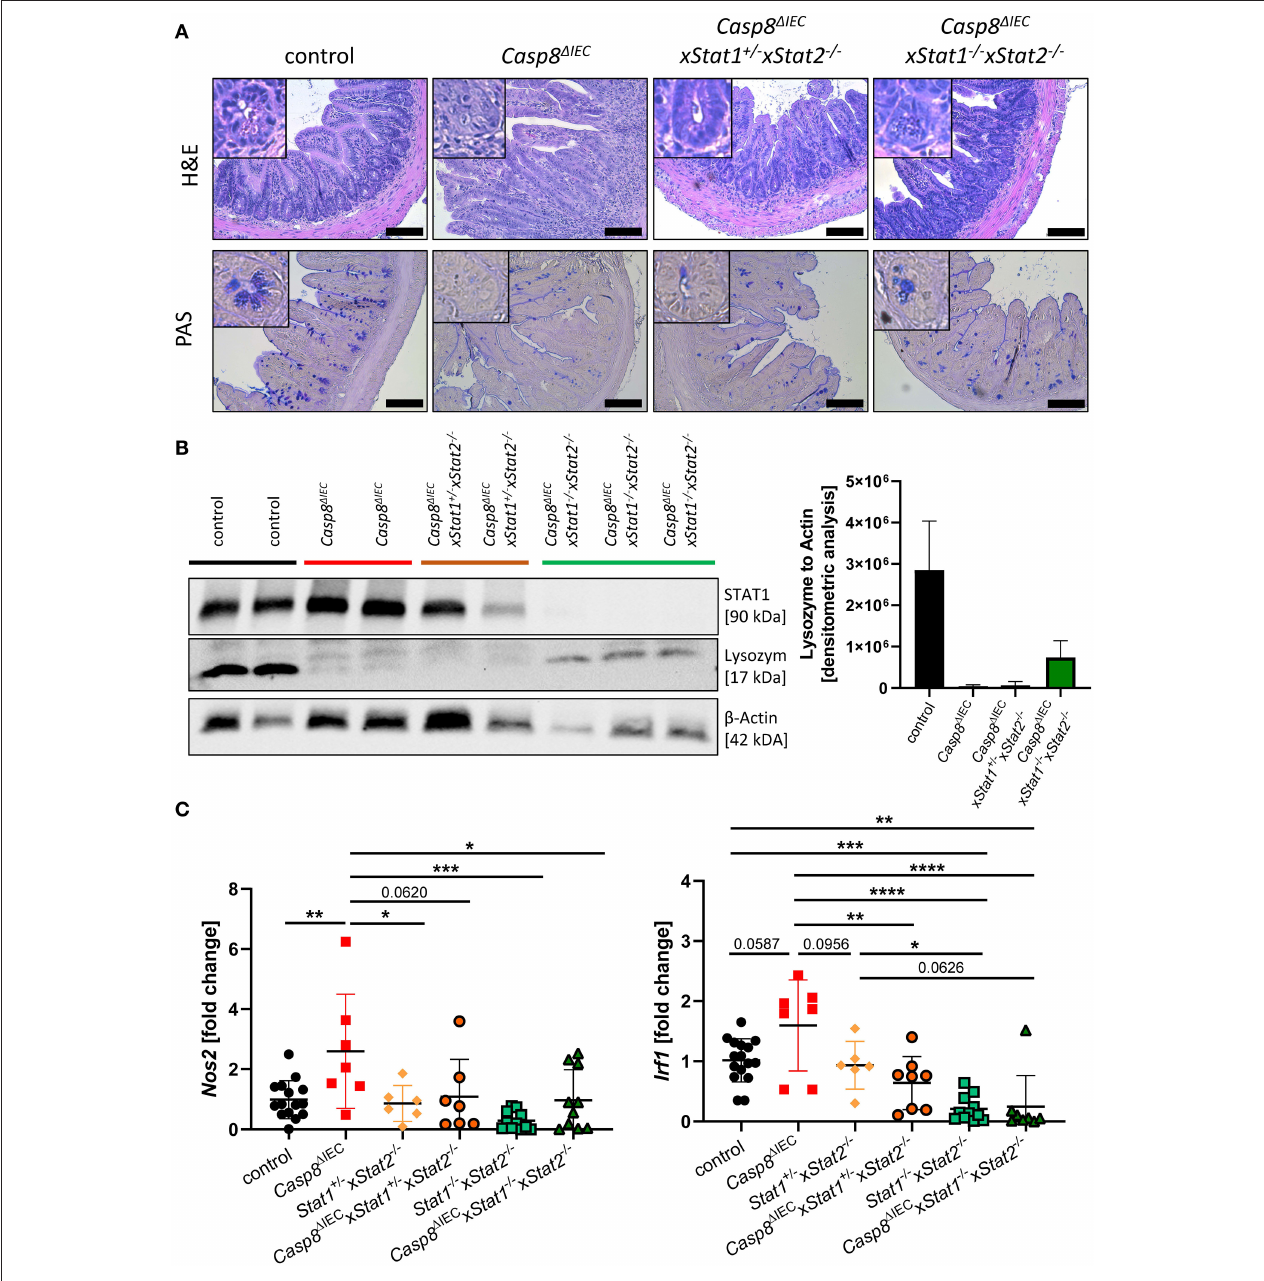
FIGURE 4 | STAT2 signaling fails to restore Paneth cell viability but alters inflammation. (A) Representative images of small intestinal tissue cross sections of control, Casp8 1 IEC , Casp8 1 IEC x Stat1 + / − Stat2 − / − and Casp8 1 IEC x Stat1 − / − Stat2 − / − mice stained with H&E and PAS (scale bar: 100 µ m). (B) Western blot analysis and normalization of ileal tissue with antibodies against STAT1 and Lysozyme. β -Actin was used as loading control. Densitometry analysis for quantification ( n ≥ 2). Error bars indicate + SD. (C) Gene transcription analysis of Mlkl mRNA expression in the small intestine. Gapdh was used as housekeeping gene. Gene expression levels are shown as fold changes. Error bars indicate + /-SD. Statistical analyses: One-way ANOVA with Tukey’s multiple comparisons test; NS p ≥ 0.05; * p < 0.05; ** p < 0.01; *** p < 0.001; **** p < 0.0001.